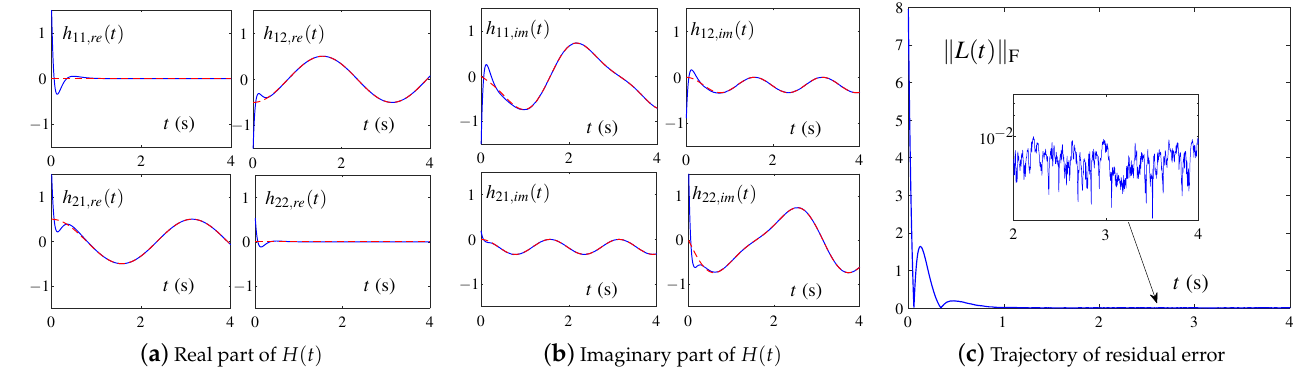
Figure 3. CNRZNN model for solving CTDLE (14) under bounded random noises [ where the solid blue line represents the state trajectory and the red dotted line stands for theoreti- cal